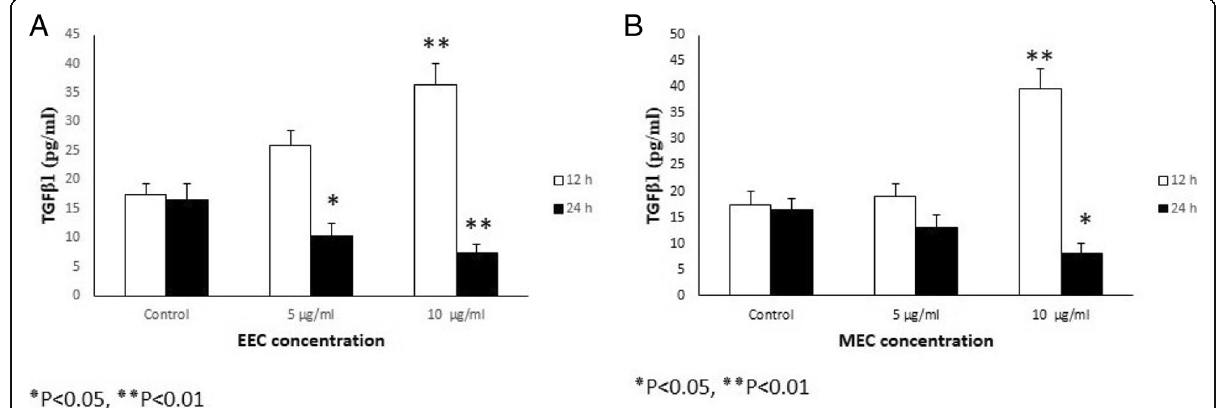
Fig. 4 Effect of various concentrations of ethanol ( a ) and methanol ( b ) extracts of Calendula the expression of TGF β 1 protein in the MEFs culture supernatants. The MEFs were treated with different concentration of ethanol and methanol extracts of Calendula (5 and 10 μ g/ml) at different time intervals treatment (12 and 24 h) and the expression of TGF β 1 protein was assessed by ELISA